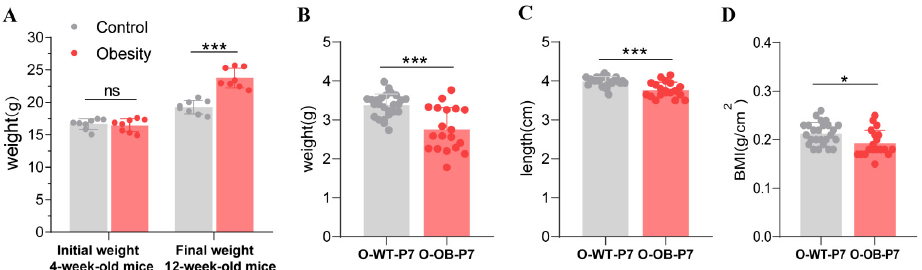
Figure 1. Effect of maternal obesity on offspring 7 ‐ day male mice at baseline. ( A ) Changes in body weight in mother after being fed a normal diet and high ‐ fat diet. ( B ) Bodyweight, ( C ) body length, and ( D ) BMI of offspring 7 ‐ day male mice in the control and obese groups. O ‐ WT ‐ P7: offspring 7 ‐ day male mice from the control mothers ( n = 25). O ‐ OB ‐ P7: offspring 7 ‐ day male mice from the obese mothers ( n = 19). BMI: body mass index. Results are expressed as mean ± SD. ns not significant, * p < 0.05, *** p < 0.001.